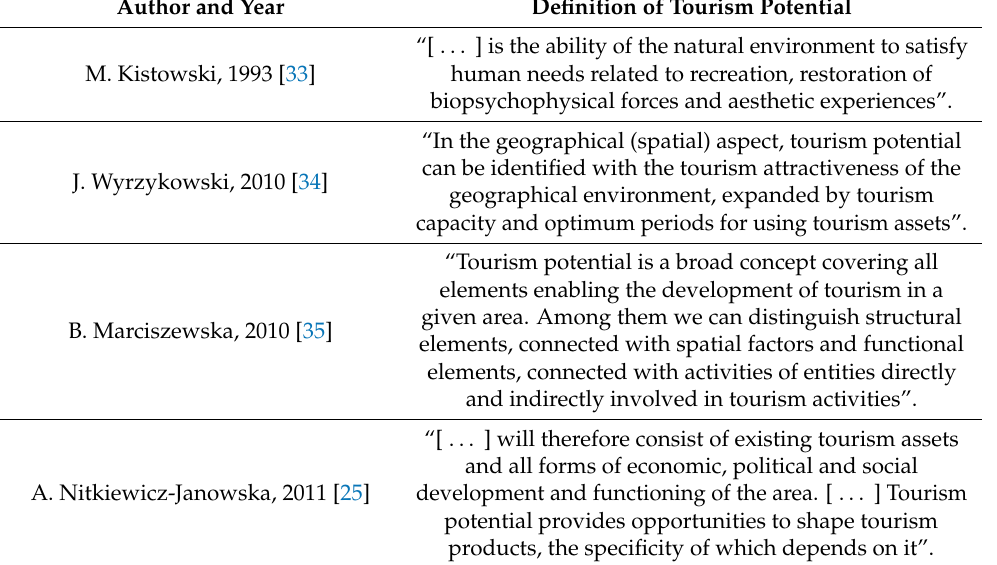
Table 2. Definitions of tourism potential according to different